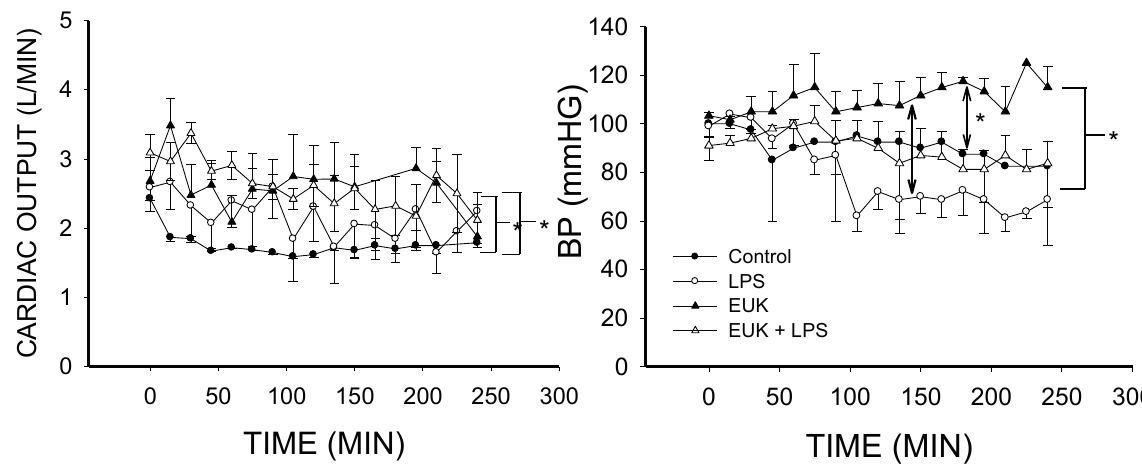
Figure 2. Cardiac output and blood pressure over time for the four conditions (mean ± SEM). Left , cardiac output (L/min) was higher in the LPS group and LPS plus EUK-134 groups than the control group ( p < 0.02 and p < 0.005, respectively). Cardiac output in EUK-134 alone was also higher than control ( p < 0.001) and LPS alone ( p < 0.005); Right , blood pressure (BP) was lowest in the LPS group but was not significantly different from control ( p < 0.068); This drop was rescued in the LPS plus EUK-134 group, which was superimposable with the control group. BP was best maintained or slightly rose in the EUK-134 group; This group was significantly greater than the LPS ( p < 0.001), control ( p < 0.001), and LPS plus